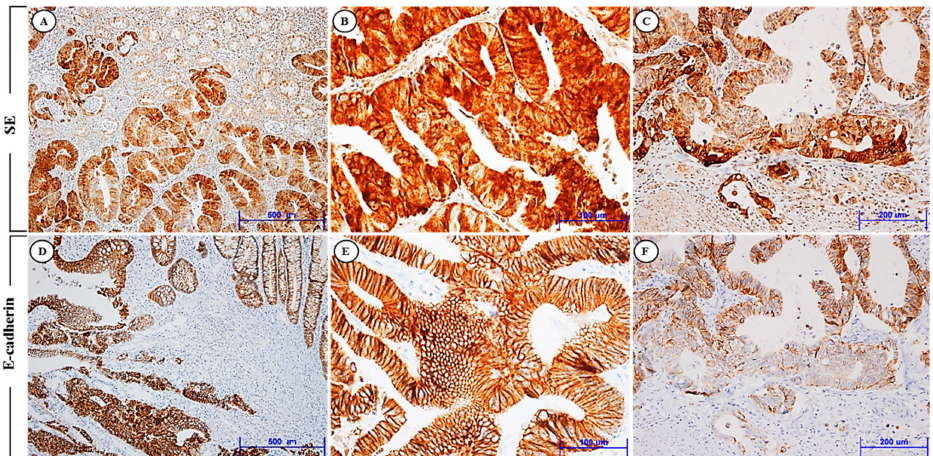
Figure1. ImmunohistochemicalexpressionofSE( A – C )andE-cadherin( D – F )inhumanCRC.( A )Tumor cells show high SE expression, but no or weak expression of SE in the normal colonic epithelium ( × 100). ( B ) Tumor cells reveal strong SE expression primarily in the cytoplasm of the tumor cells ( × 400). ( C ) SE expression is highly increased in the tumor cells of the invasive front ( × 200). ( D ) Strong immunoreactivity of E-cadherin in the normal colonic epithelium and tumor cells ( × 100). ( E ) E-cadherin is highly expressed, predominantly in the membrane of the tumor cells ( × 400). ( F ) E-cadherin expression